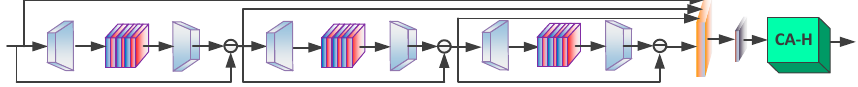
Figure 5. Details of the HFM which contains three down- and up-projection errors and one channel-wise attention module based on high variance.